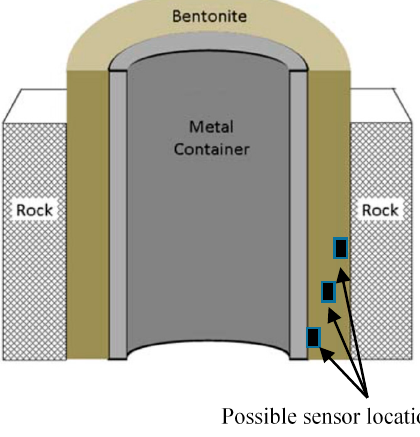
Figure 1. Schematic cross-section through the bentonite engineered barrier system.